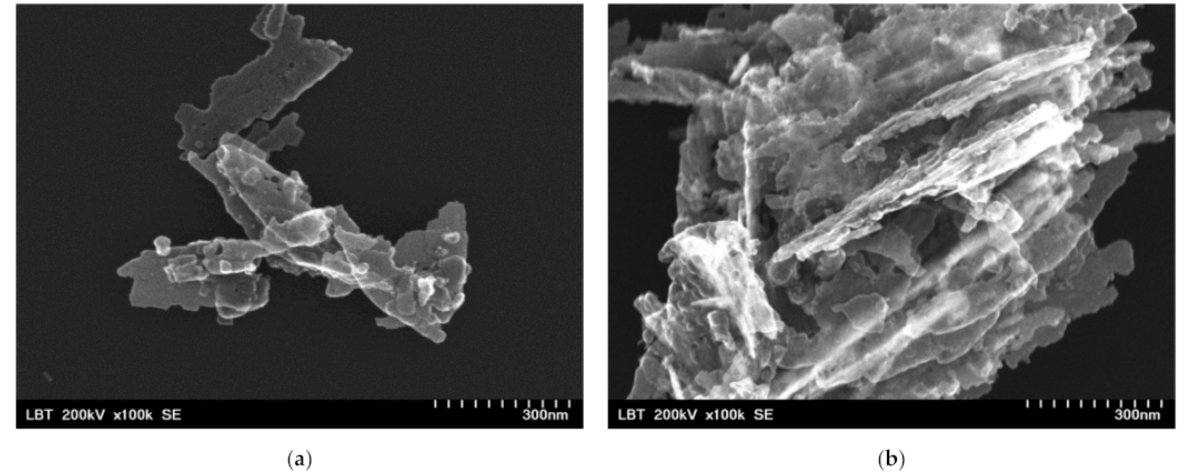
Figure 2. SEM images for ZnO:Fex nanostructures: ( a ) ZnO:Fe0 and ( b ) ZnO:Fe0.7.